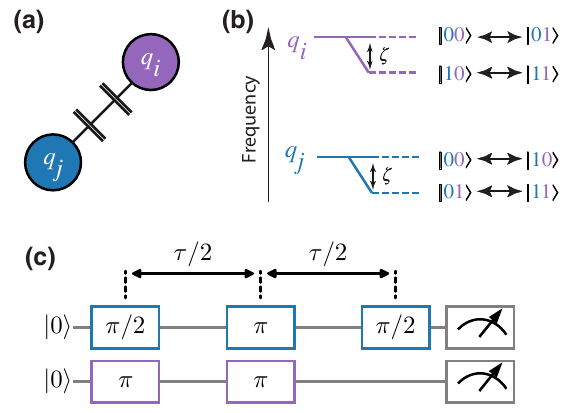
FIG. 16. Residual ZZ interactions in multiqubit devices. (a) Two neighboring qubits q i and q j are coupled through a coupling resonator. (b) At their idle frequencies, both qubit frequencies are slightly dependent on the state of the other qubit with strength ζ